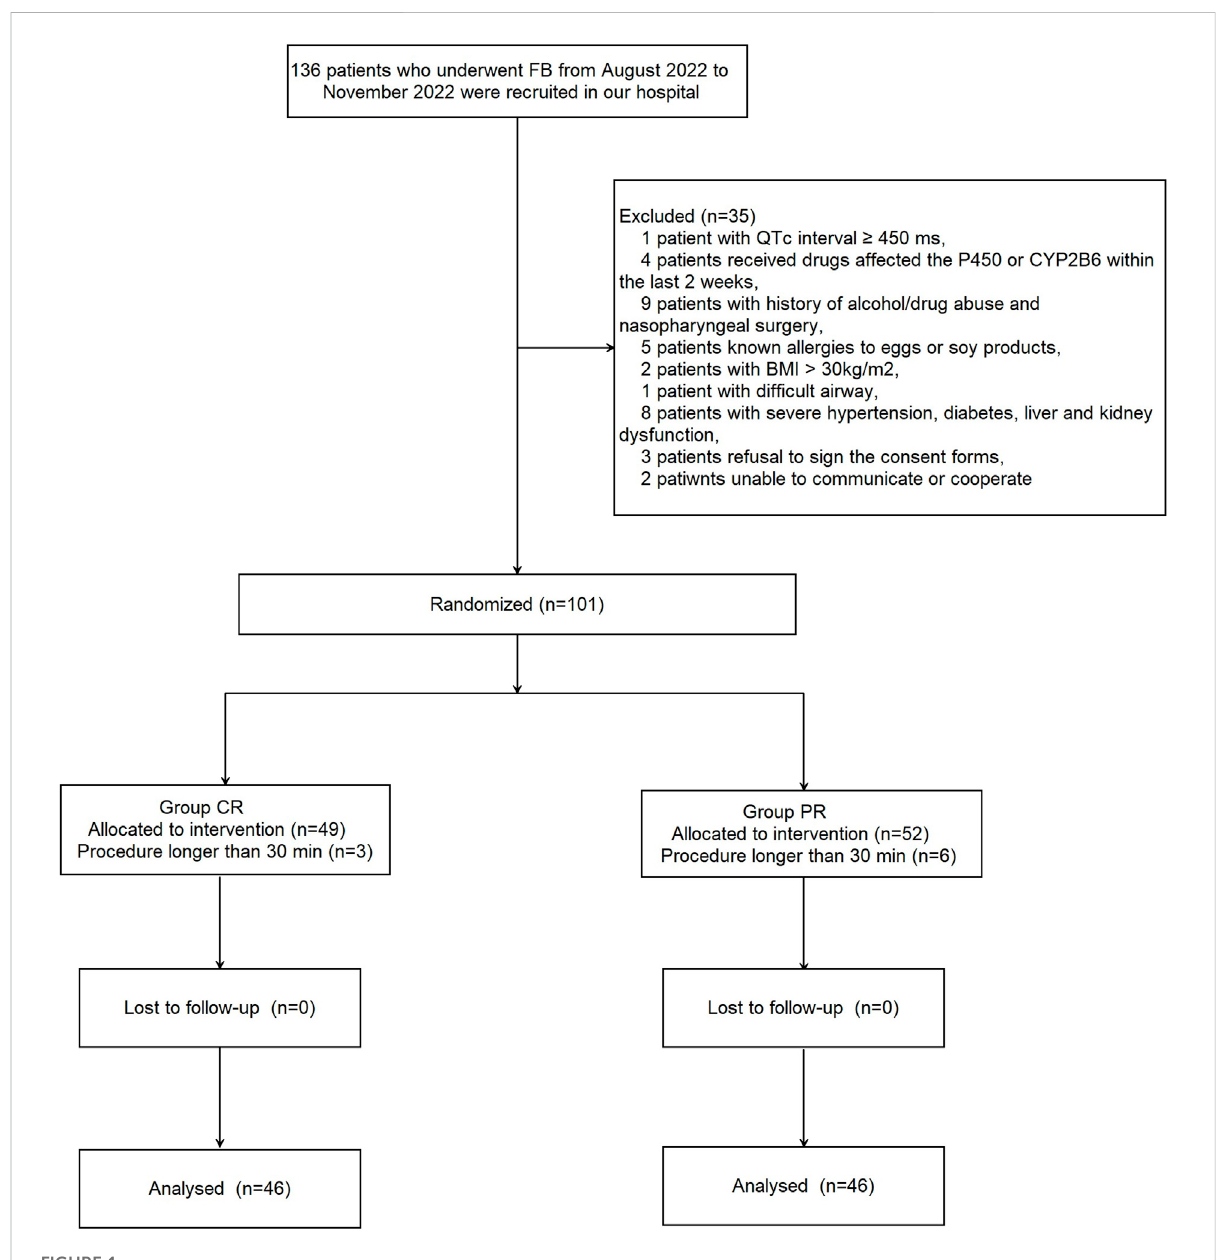
Patient fl owchart with CONSORT